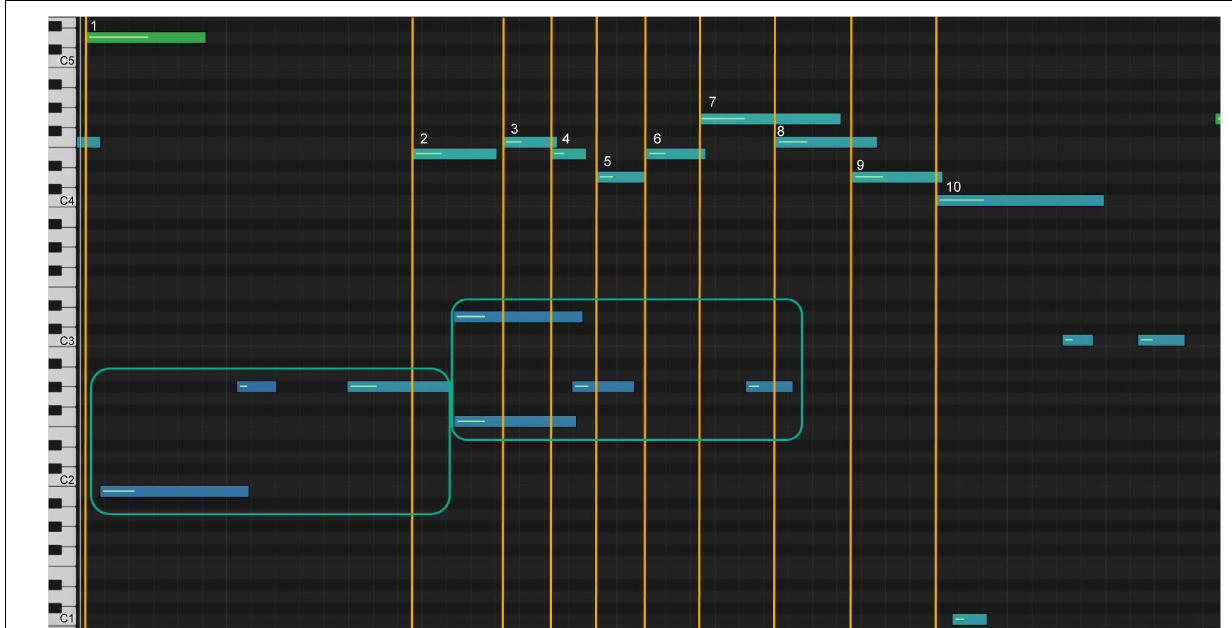
FIGURE 12 | Sonification graph of model C’s highpoint.